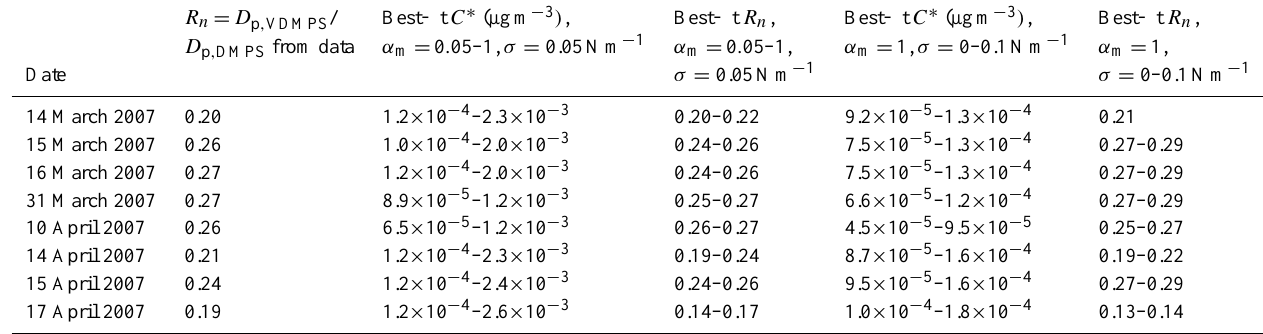
Table 4. The single-component saturation concentrations C ∗ corresponding to the best fits between measured and modelled ratios between ambient (DMPS) and heated (VDMPS) particle diameters during a selection of atmospheric nucleation events in Hyyti¨al¨a, Finland.